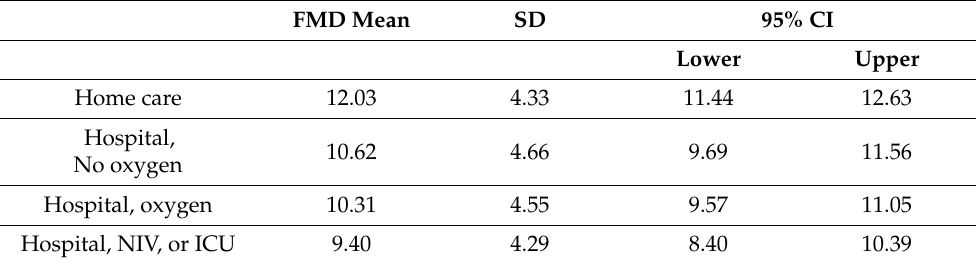
Table 2. Mean of flow-mediated dilation according to different categories of disease severity (see Table 3 for multiple comparisons among COVID-19 categories).